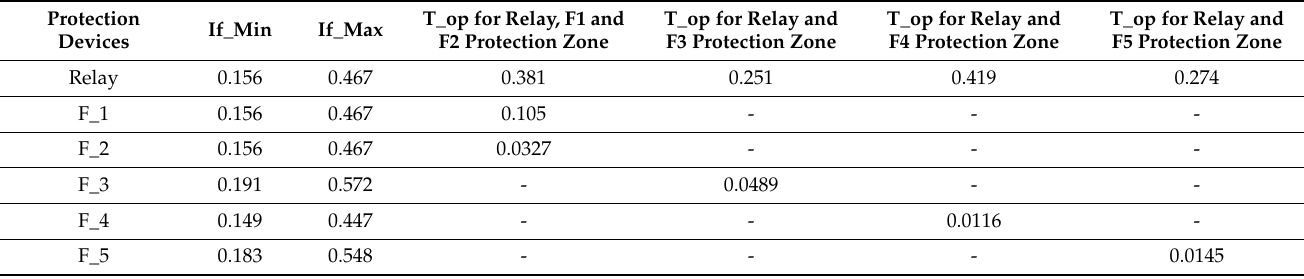
Table 6. Restored network protective condition considering protection constraints.